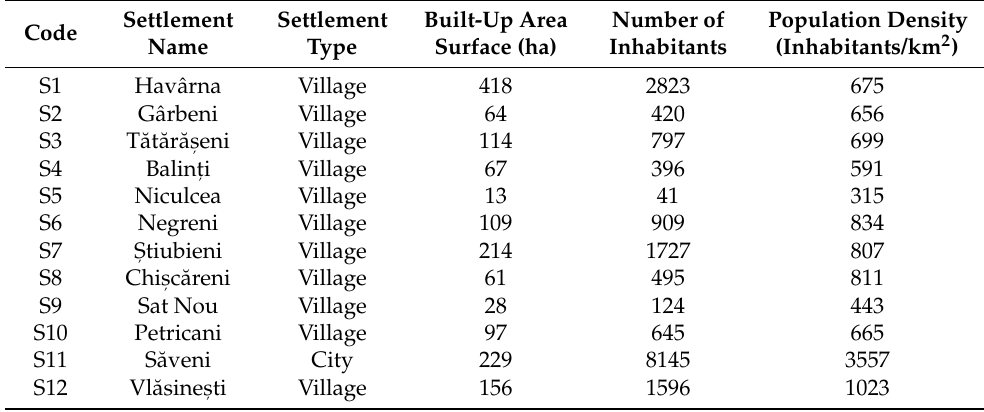
Table 2. Settlement codes and habitation features within Ba¸seu multi-reservoir system according to the 2016 census